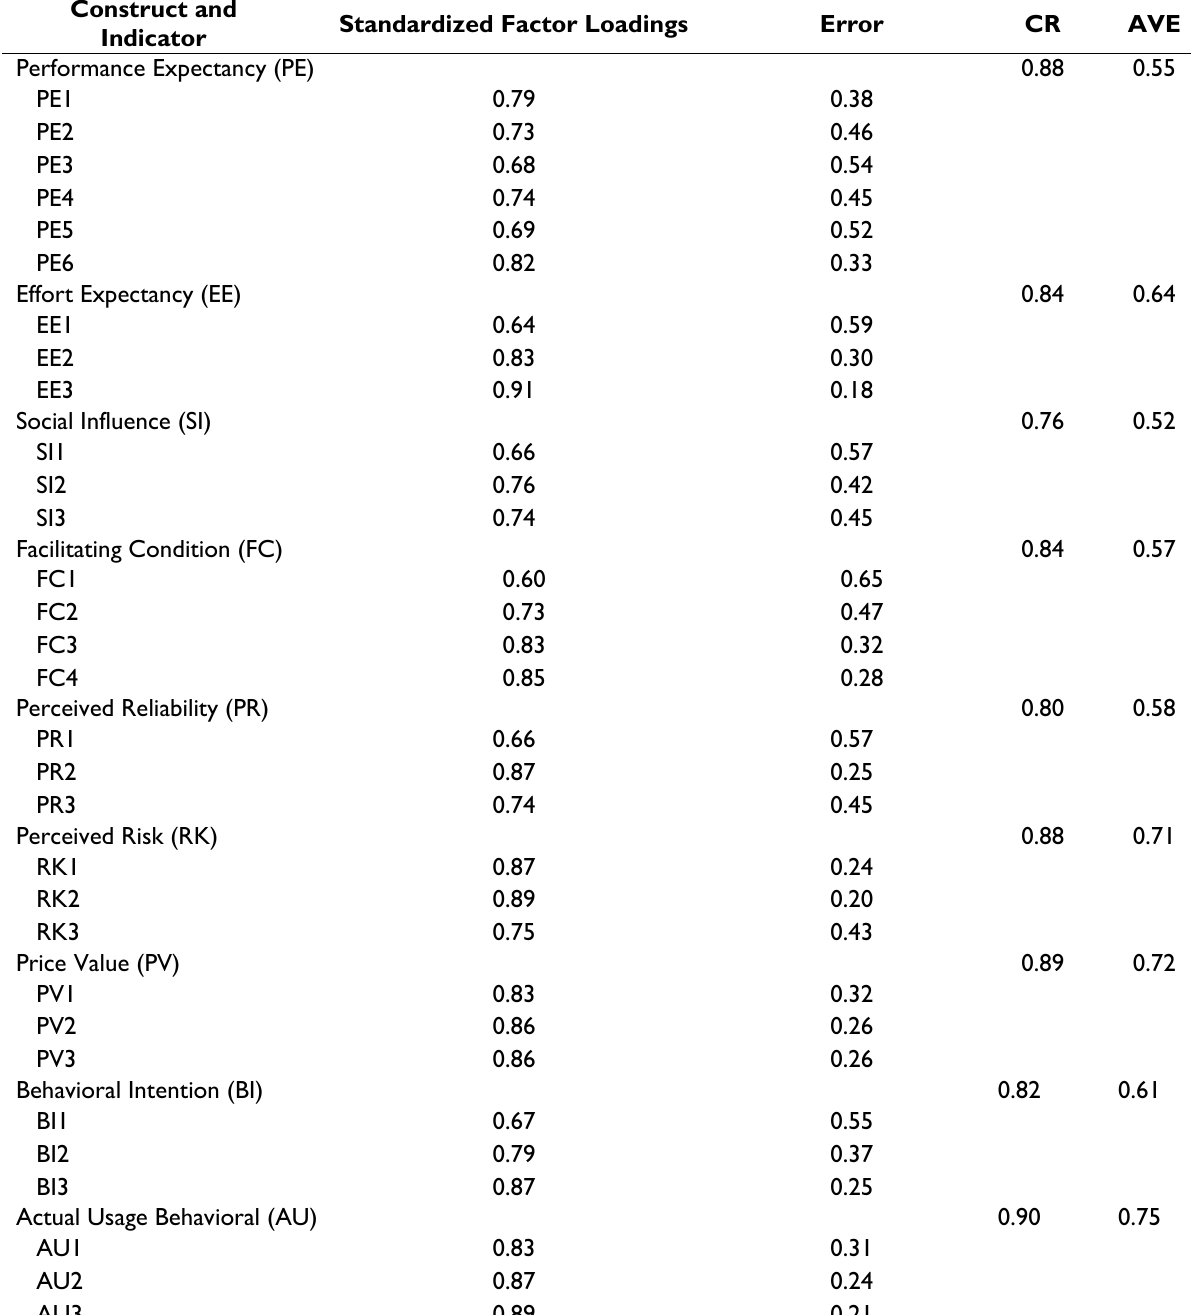
Table 3. Convergent validity and reliability Construct